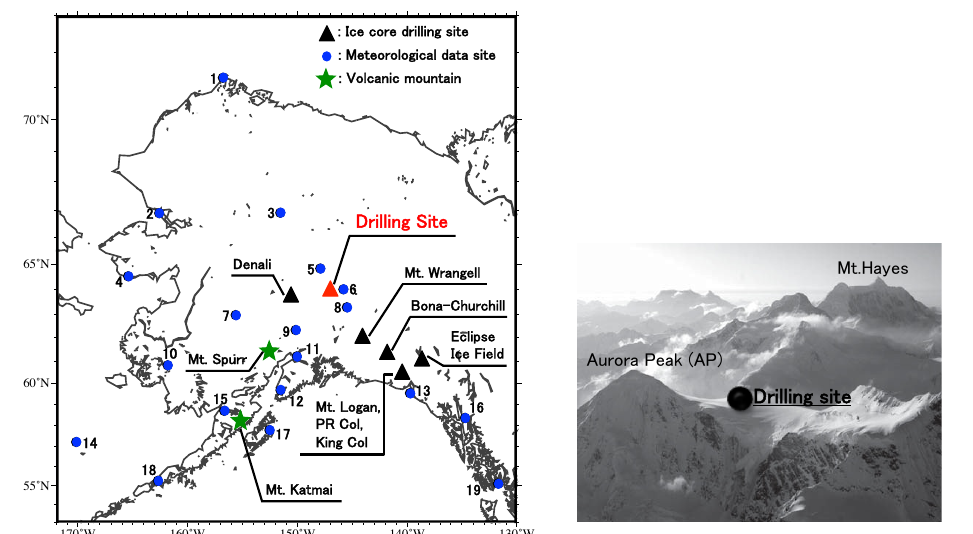
Figure 1. Location of the study area and drilling site at Aurora Peak in the central Alaska Range and meteorological data sites. (Meteoro- logical data sites: 1 Barrow, 2 Kotzebue, 3 Bettels, 4 Nome, 5 Fairbanks, 6 Big Delta, 7 McGrath, 8 Gulkana Glacier, 9 Talkeetna, 10 Bethel, 11 Anchorage, 12 Homer, 13 Yakutat, 14 St Paul, 15 King Salmon, 16 Juneau, 17 Kodiak, 18 Cold Bay, 19